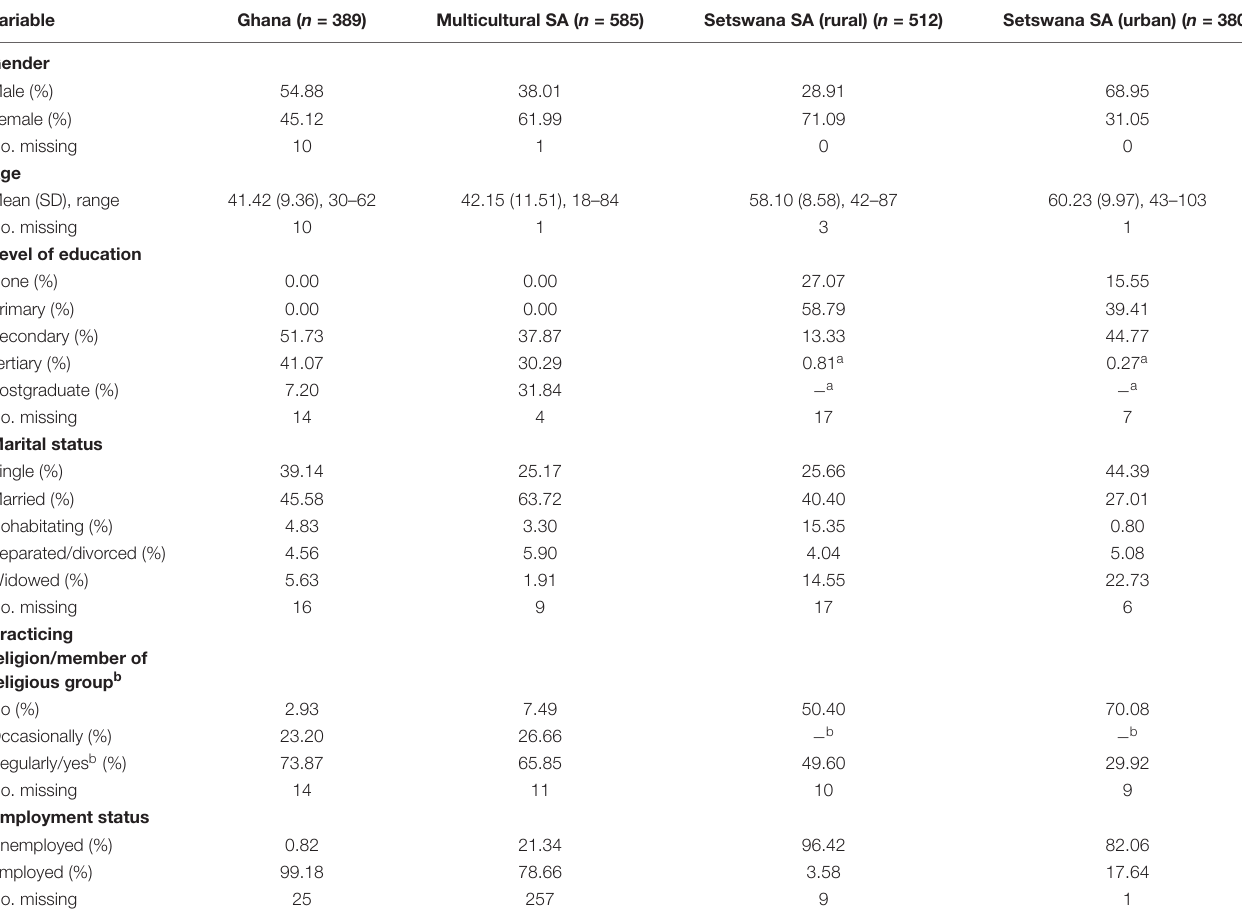
TABLE 1 | Demographic profile of the four